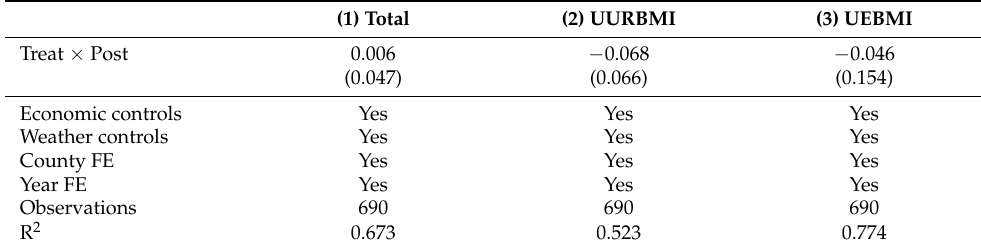
Table 7. Robustness checks: alternative treatment